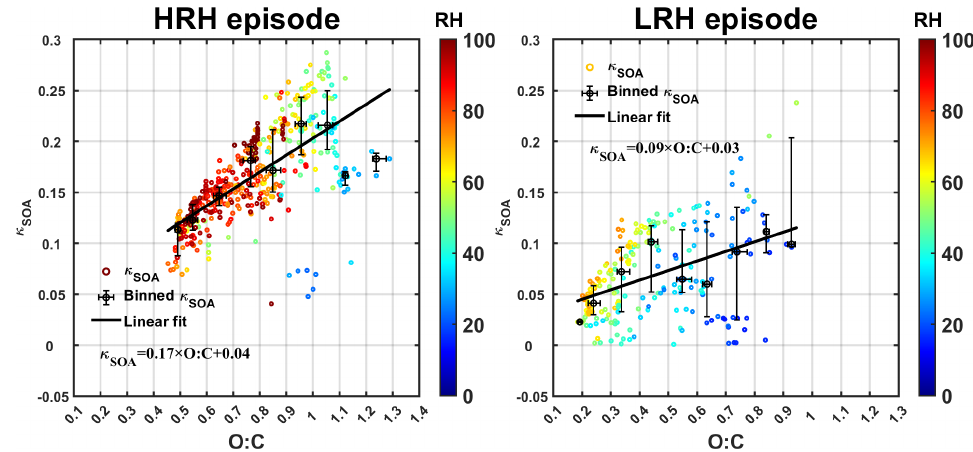
Figure 8. The plots of κ SOA vs. O : C ratios during the HRH and LRH episodes. The black line is the fitting to the measured data. The black point is the data that κ SOA values were binned by O : C with an increment of 0.1. The color bars indicate